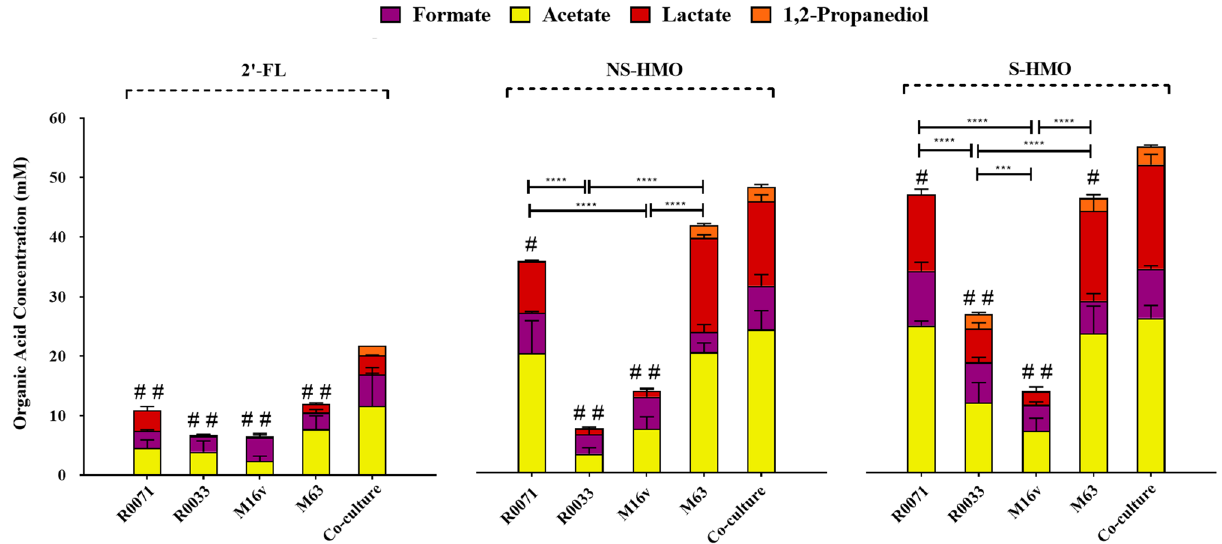
Figure 3. Levels of organic acids and 1,2-propanediol (1,2-PD) produced after 10 h of growth of the bifidobacterial strains as mono-cultures and as a four strain co-culture. The following HMO were used as the sole carbon source: 2 ′ -FL [1.2 g/L], model of NS-HMO [3.8 g/L] and a model of S-HMO [5 g/L]. Levels of acetic acid, formic acid, and lactic acid were quantified using HPLC coupled with an RI detector. Levels of 1,2-PD were quantified using GC–MS. R0071 = Bifidobacterium bifidum R0071, R0033 = Bifidobacterium infantis R0033, M-16V = Bifidobacterium breve M-16V, M-63 = Bifidobacterium infantis M-63. Analysis was calculated using technical duplicate data from biological triplicate experiments and data are means + /− SD. Univariate analysis of variance (ANOVA) and post-hoc Tukey tests were performed to determine the significant differences between the groups (# = p < 0.05, ## = p < 0.001 vs. co-culture) (* = p < 0.05, ** = p < 0.01, *** = p < 0.001, **** = p < 0.0001 between other strain